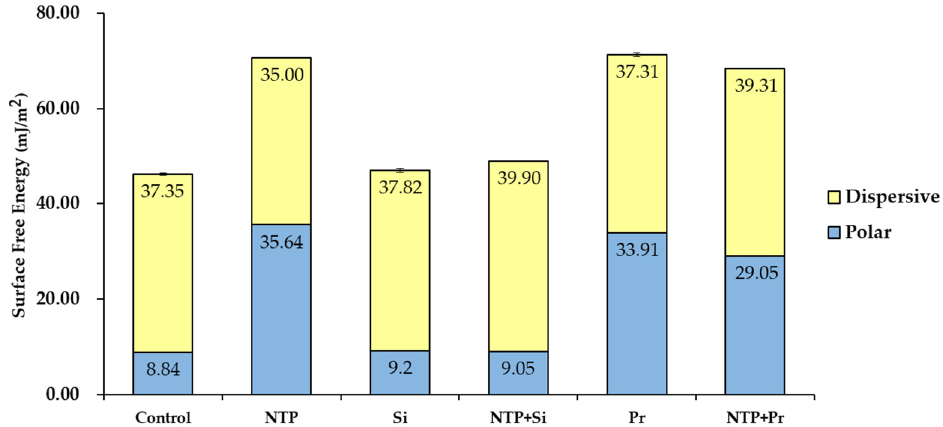
Figure 7. Average polar and dispersive values of SFE for zirconia surface. The sum of both compo- nents represents the total SFE value.